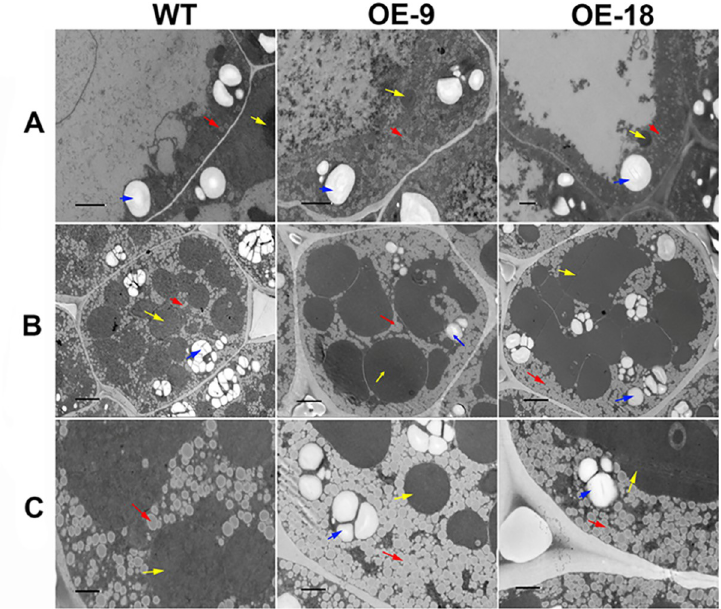
Fig 6. Microscope analyses of OBs in WT and OE seeds. A, OBs in WT and OE seeds at 25 DAF, scale bars = 3 μ m. B, Distribution of OBs in a whole seed cell at 40 DAF, scale bars = 5 μ m. C, Increased magnification of OB distribution in a seed cell at 40 DAF, scale bars = 2 μ m. The seed cells in OE-9 and OE-18 appear to contain smaller OBs than those in WT. Red arrows, oil body; yellow arrows, protein body; blue arrows, starch